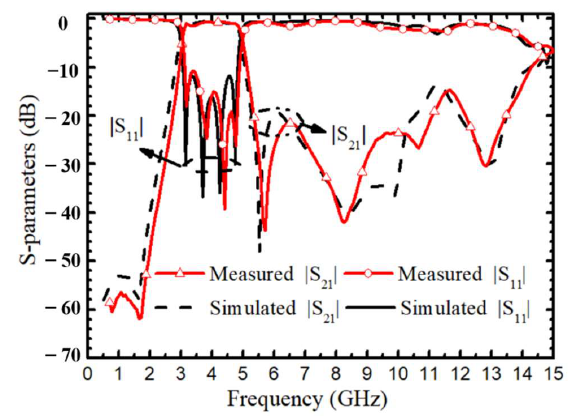
Figure 12. The simulated and measured responses.